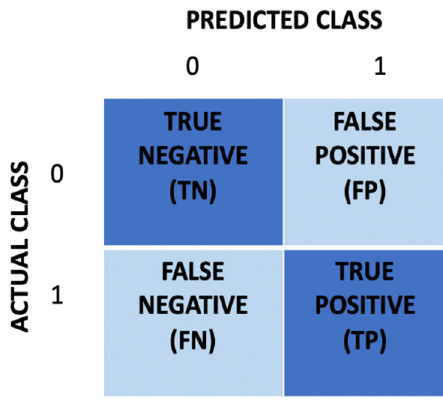
Figure 8. Confusion matrix for two classes.